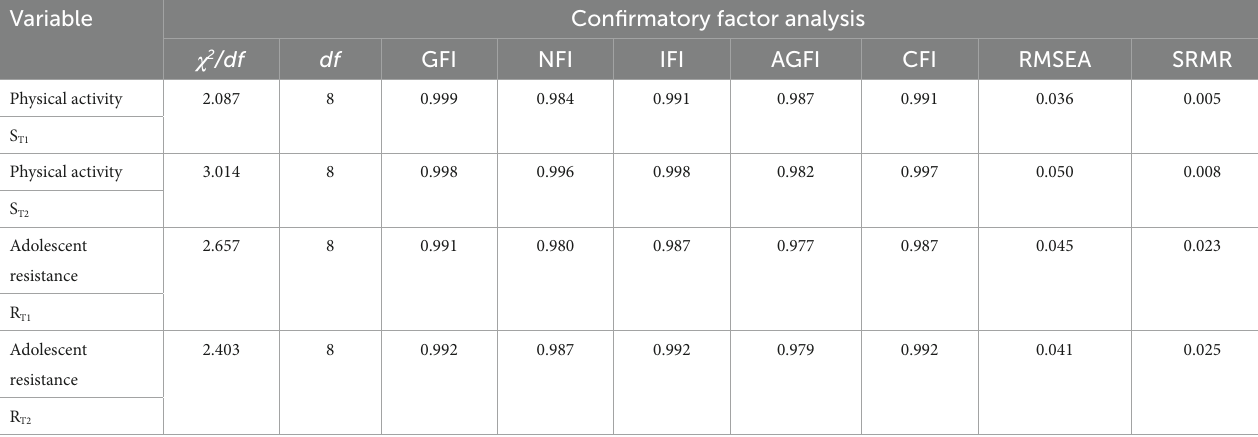
TABLE 3 Confirmatory factor analysis indicators of physical activity and adolescent resilience.